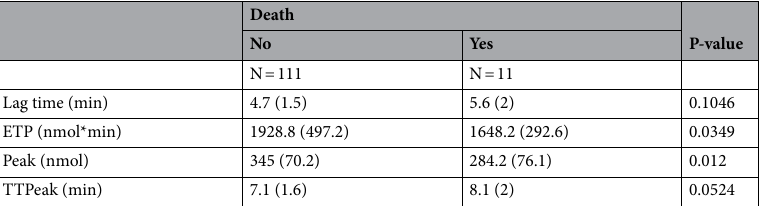
Table 5. Association between thrombin generation and hospital mortality. Variables are presented as the mean (SD). Min minute, ETP endogenous thrombin potential, TTPeak time to